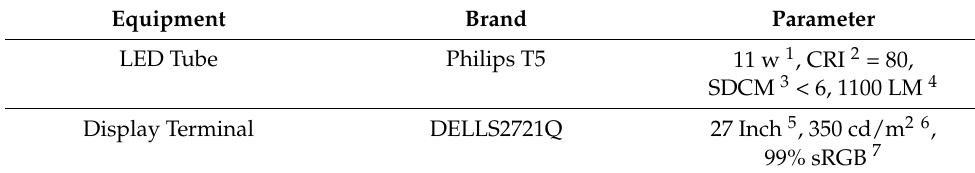
Table 1. Parameters of experimental equipment.